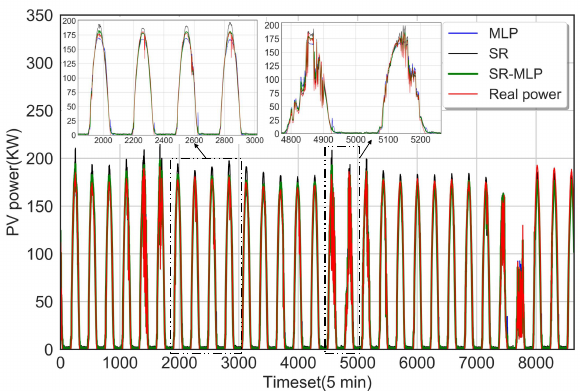
Figure 10. Performance investigation of the PV power forecasting using different